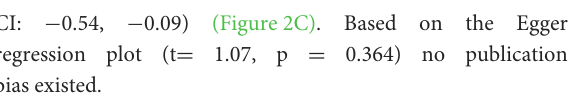
CI: − 0.54, − 0.09) (Figure 2C). Based on the Egger regression plot (t = 1.07, p = 0.364) no publication bias